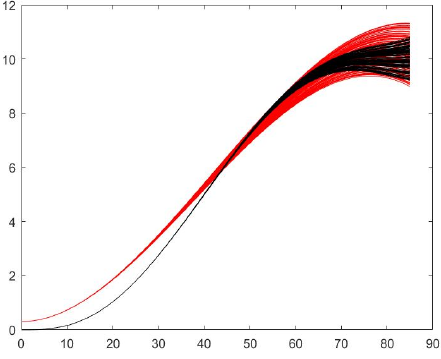
Figure 7. Example showing 100 curves of ϕ 1 and ϕ 2 .